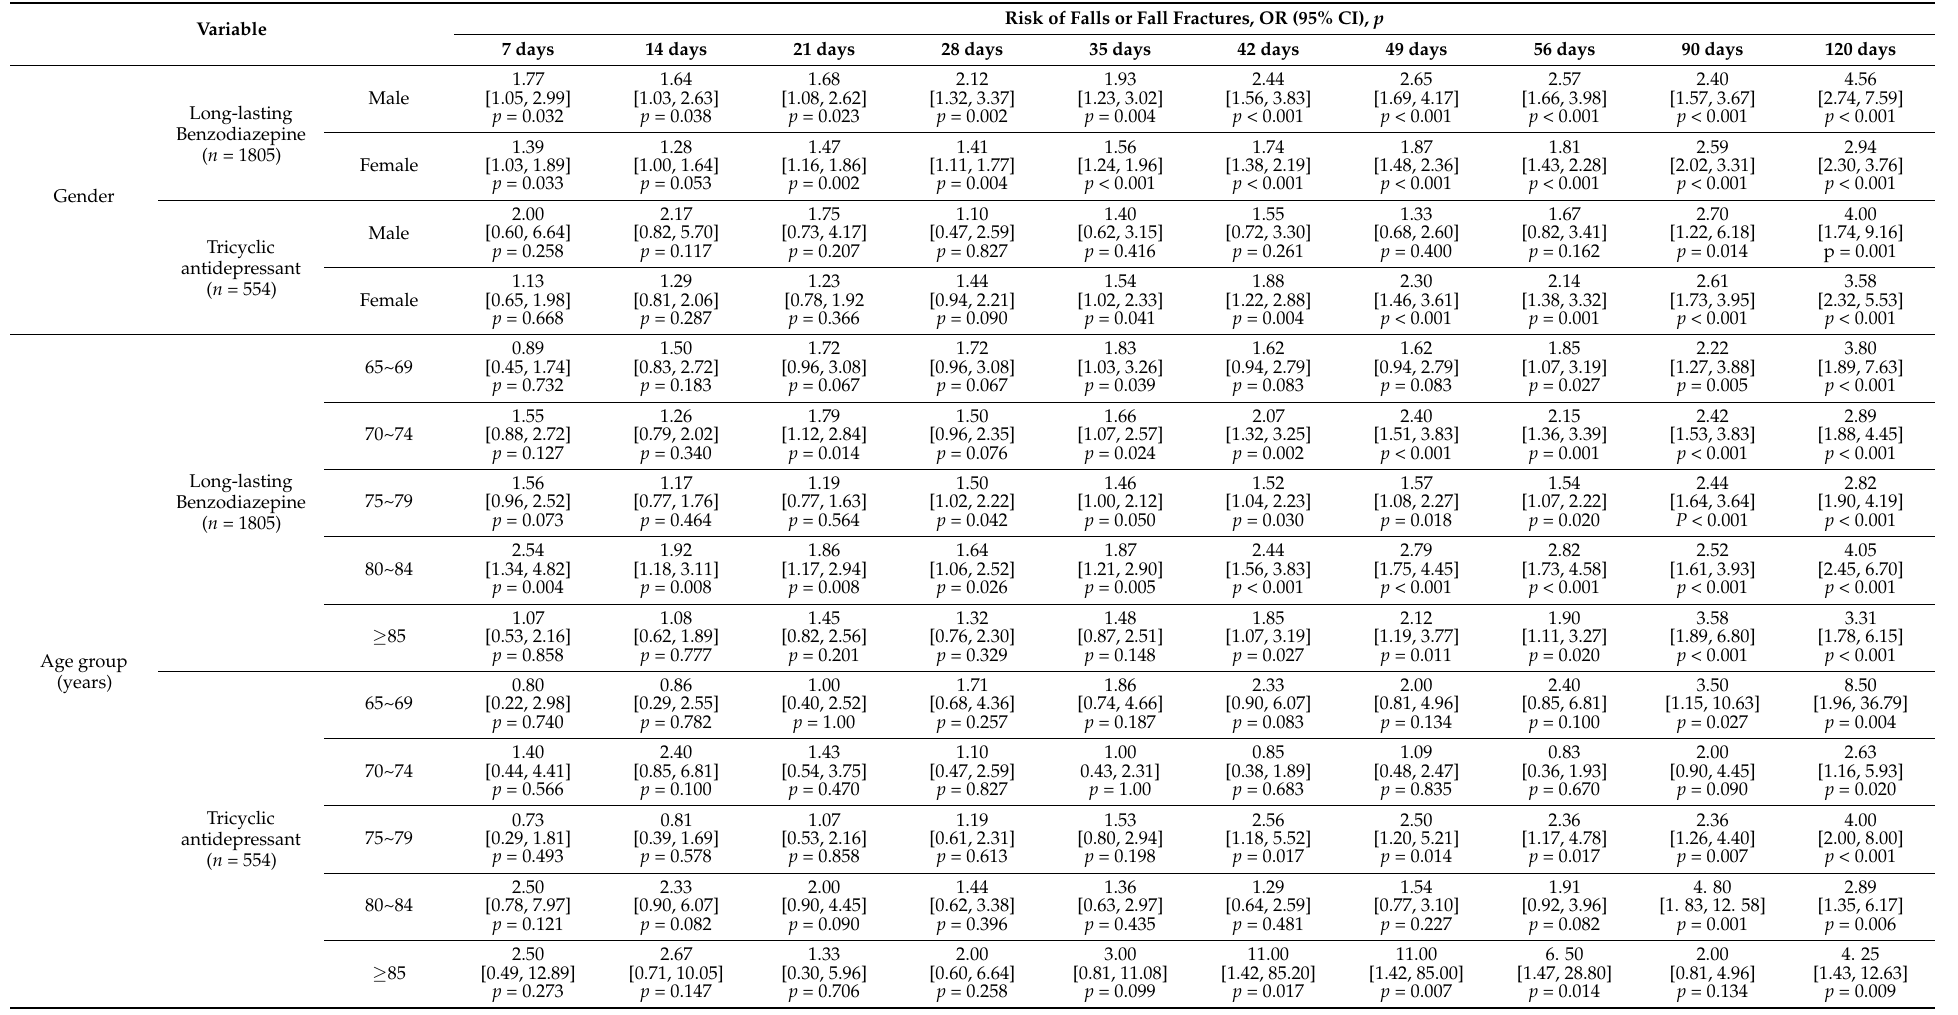
Table 3. Risk of Falls or Fall Fractures from Long-lasting Benzodiazepines or Tricyclic antidepressants based on Prescription Period by Gender, and Age Group ( n =